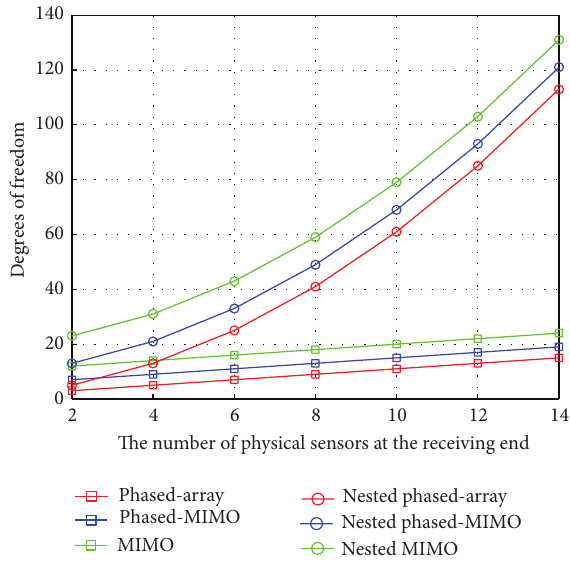
Figure 3: Comparative DOF versus sensors’ number.